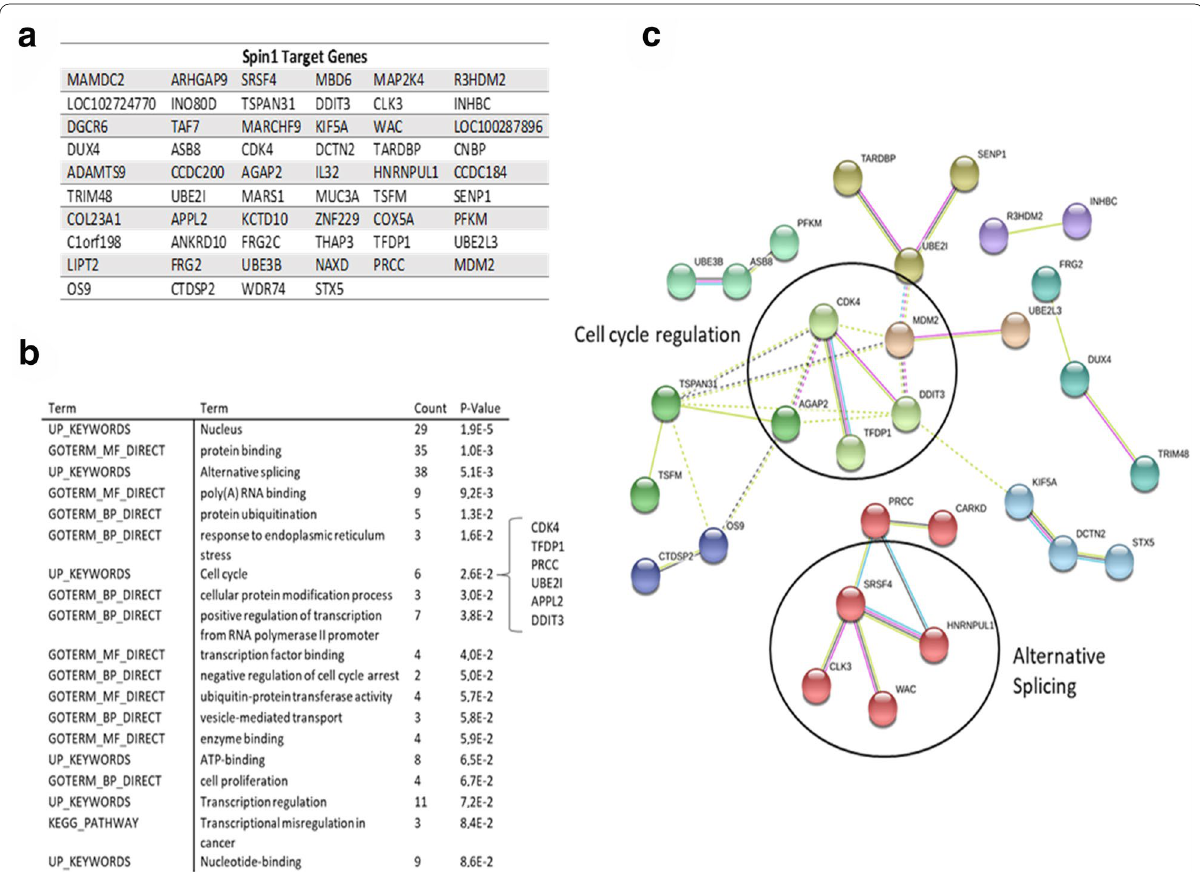
Fig. 6 Bioinformatic analysis of the Spindlin1 target genes. a List depicting the predicted genes bound by Spindlin1 in human cells, retrieved from the ChIP-Atlas database. b Functional annotation analysis of the identified in genes shown in a . The analysis was performed using the DAVID bioinformatics software. c Protein–protein interaction network of the Spindlin1 target genes. Analysis was performed using the string